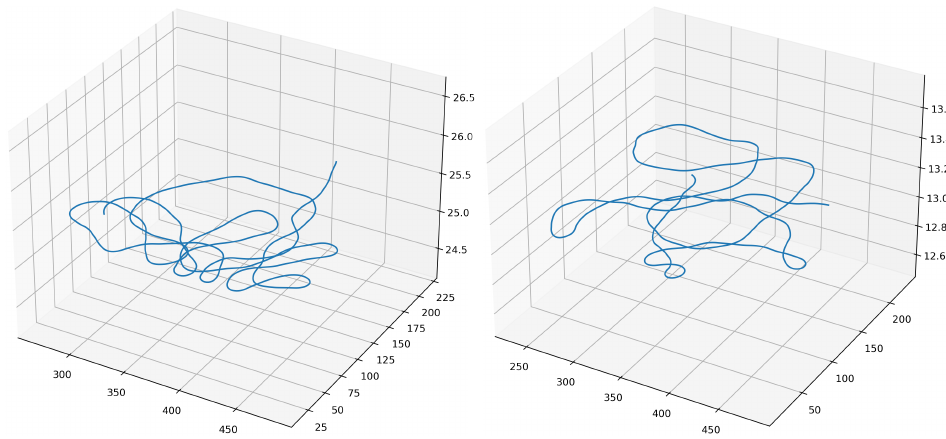
Figure 5. Samples of the generated paths using